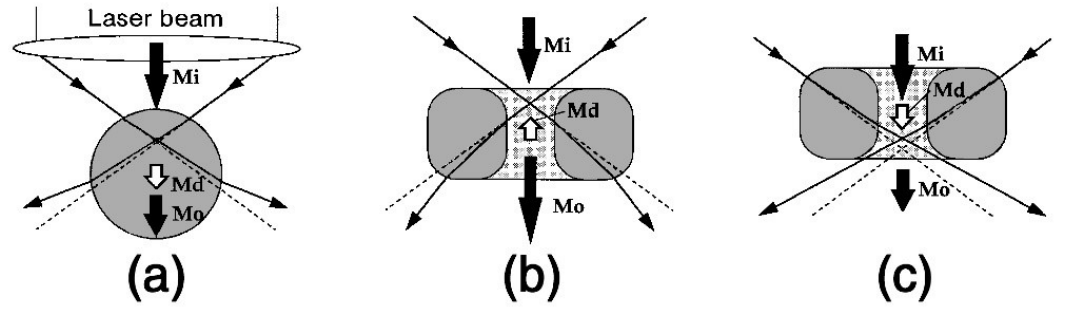
Figure 5. Illustration of the interaction of the optical tweezers with differently shaped low-refractive index particles, and the impact of the position of the beam waist. In ( a ) and ( c ) the object shape and the beam waist position act to push the object out of the trap, whereas in ( b ) the incident forces are balanced on the inner walls of the ring, and the position of the beam waist in the Z direction acts to pull the object towards the waist, producing a stable trap. Mi is the incident momentum, Mo is the outgoing momentum and Md is the momentum transferred from the light to the object. Reproduced with permission from Reference [141] c (cid:13) The Optical